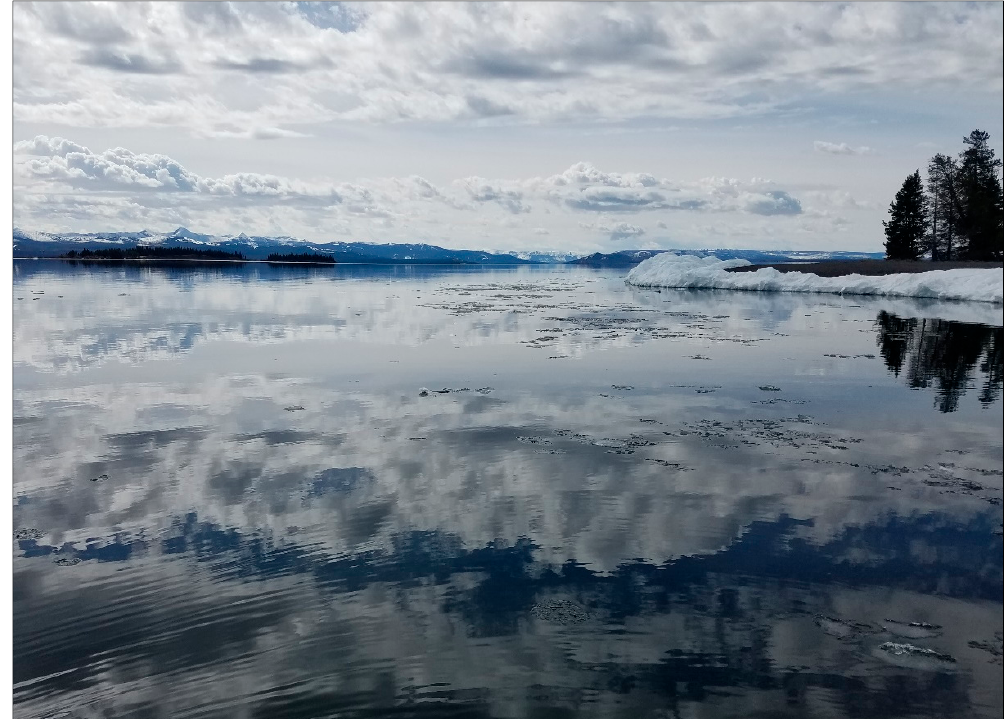
Figure 2. Yellowstone Lake in Yellowstone National Park on 26 May 2019. Yellowstone Lake is the largest alpine (above 2000 m) lake in North America and has a surface area of 34,000 ha, 239 km of shoreline, mean depth of 48 m, maximum depth of 137 m, and volume of 1.5 × 10 10 m 3 [38,39].